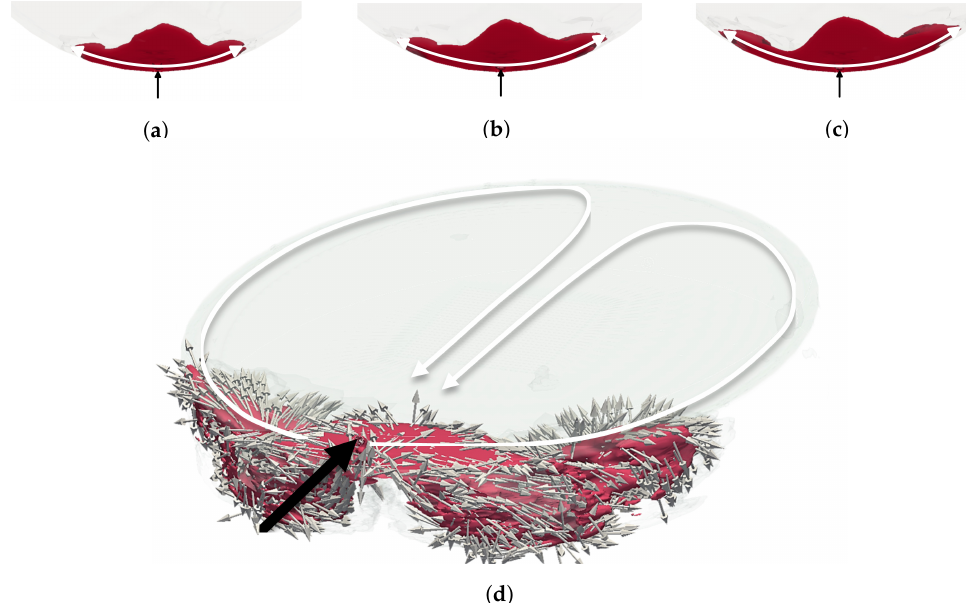
Figure 7. Water progression in the pool from the jet at ( a ) 9 s; ( b ) 12 s; ( c ) 15 s; ( d ) 50